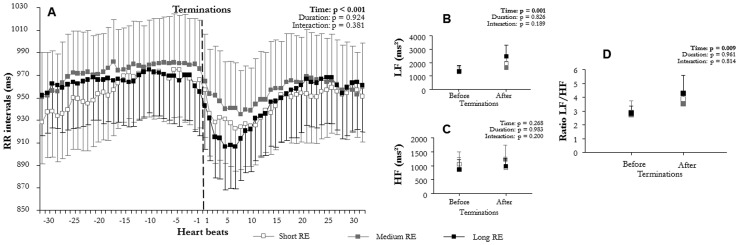
Comparison of autonomic modulation at hypopnea terminations according to hypopnea duration: (A) RR intervals (RR), (B) low (LFWV) and (C) high frequency (HFWV) wavelet power, and (D) LFWV/HFWV ratio before and after terminations according to hypopnea duration: short (10 s≤hypopneas<20 s), medium (20 s≤hypopneas<30 s), and long (hypopneas≥30 s) (mean ± SEM).An overall effect on RR intervals, LFWV, and LFWV/HFWV ratio appeared between before and after hypopnea terminations. Hypopneas induced a sympathetic-dependent RR decrease, which was not modulated by hypopnea duration.